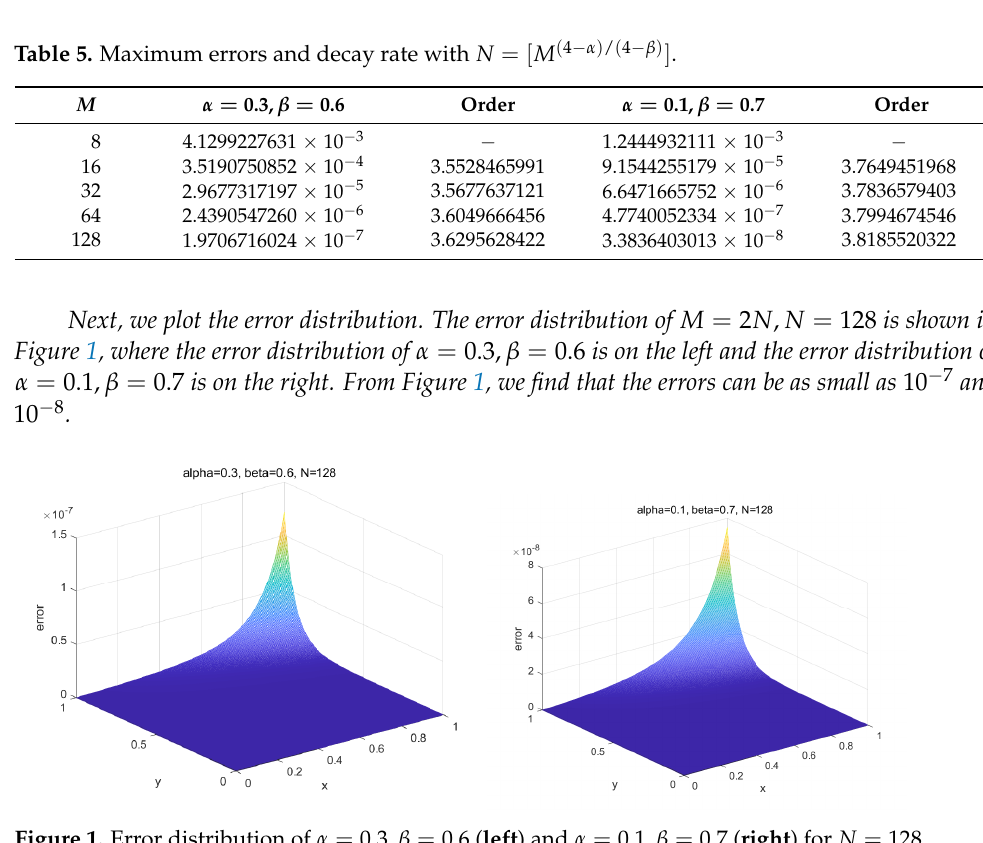
Figure 1. Error distribution of α = 0.3, β = 0.6 ( left ) and α = 0.1, β = 0.7 ( right ) for N =